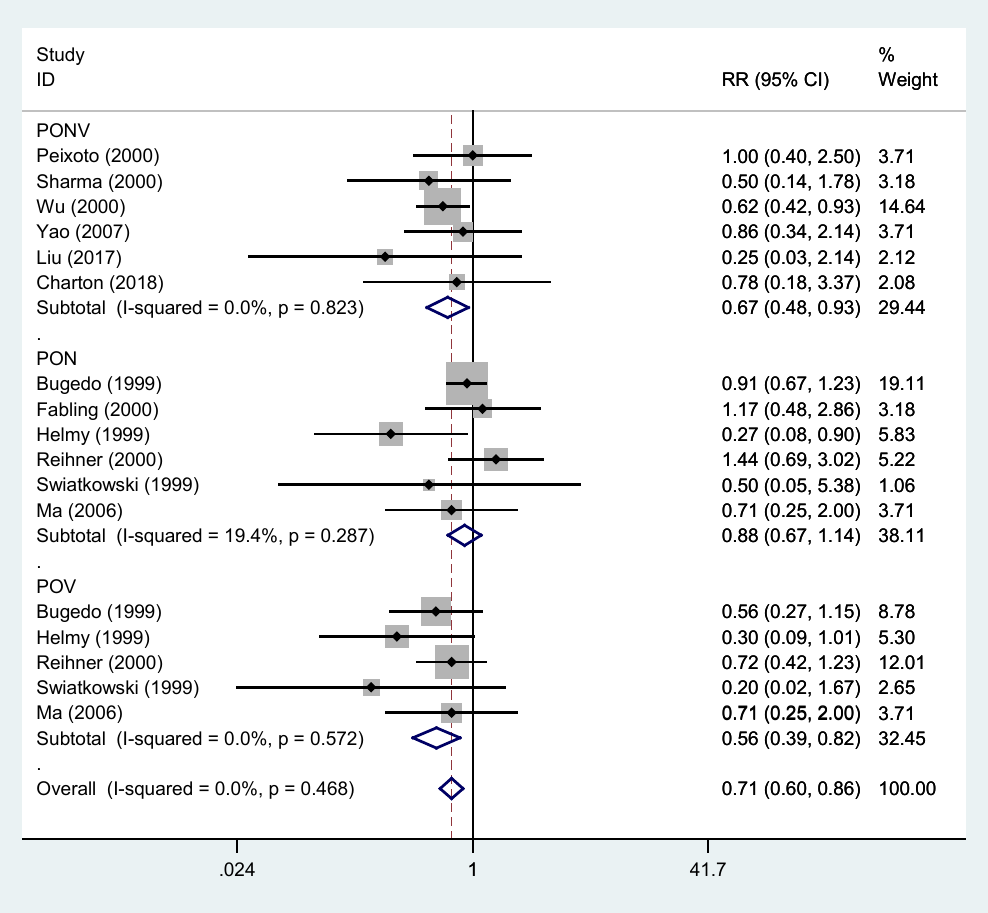
Figure 1 : The RCTs electronic searching flow-chart.